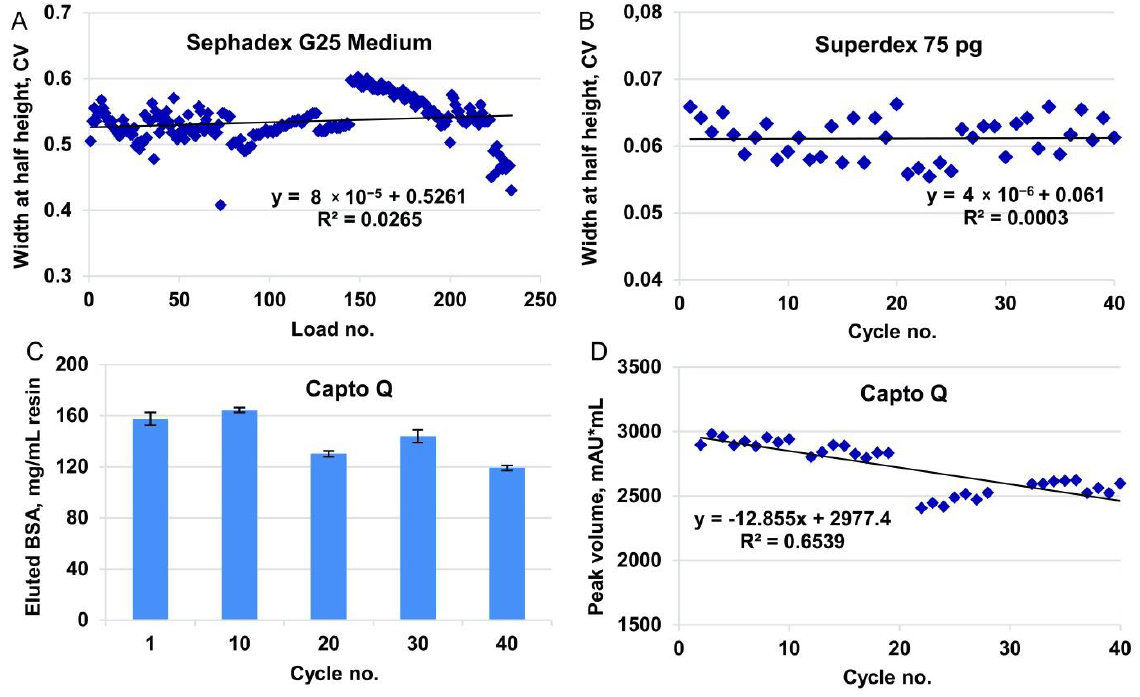
Figure 4. Stability studies for desalting by size-exclusion, ion exchange chromatography, and final size-exclusion chromatography (steps 3, 4, and 5, accordingly). ( A ) Eluate peak broadening for Tricorn 5/200 column, bed volume 4 mL, Sephadex G25 Medium resin (downscaling 1:500), conductivity channel, 40 cycles, six loads in each cycle. Sample volume 0.75 mL. ( B ) Eluate peak broadening for Tricorn 10/300 column, bed volume 24 mL, Superdex75 pg resin (downscaling 1:100), absorbance channel at 280 nm, 40 cycles. Sample volume 1 mL. ( C ) BSA eluted from Capto Q column in control cycles. Tricorn 5/50 column, bed volume 1 mL, Capto Q resin (downscaling 1:50). Loaded 320 mg BSA/mL resin, residence time 1.67 min. BSA content measured by absorption at 280 nm of the collected eluates. ( D ) Peak volume integration for eluates in working cycles, absorbance channel at 280 nm. Same column as in panel C. Loaded 30 mg BSA/mL resin, residence time 1.67 min.